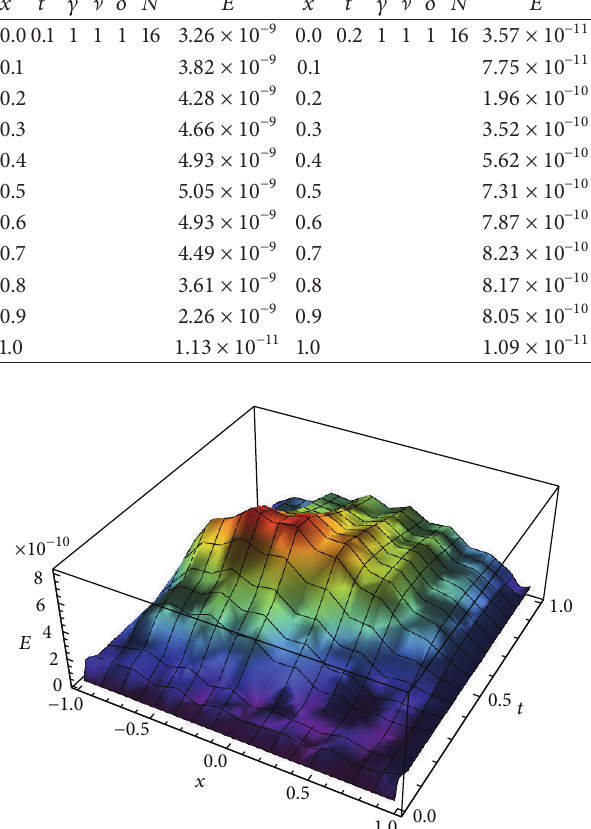
Figure 10: The absolute error of problem (44) where 𝛼 = 𝛽 = 1/2 and ] = 𝛾 = 10 −2 at 𝑁 = 20